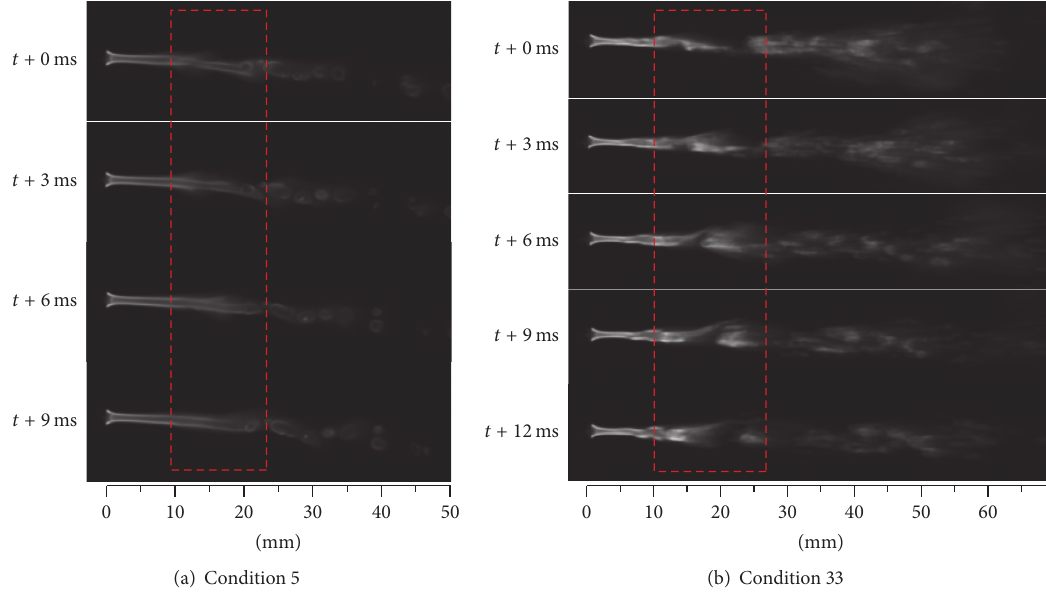
Figure 6: The change of instantaneous images in ethanol flame.